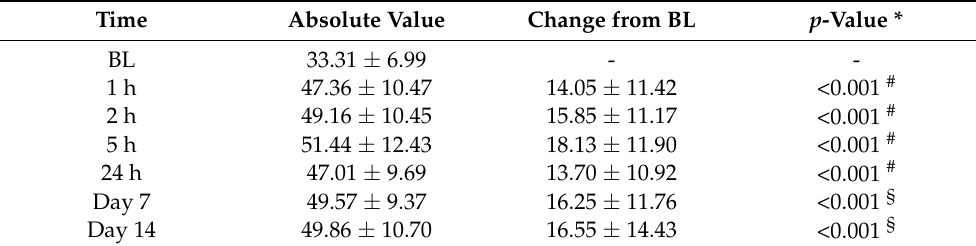
Table 1. Absolute skin capacitance measurement values (face, area F2) and changes from baseline after a single application of the face wash gel (first 24 h) followed by twice-daily applications for 13 days.